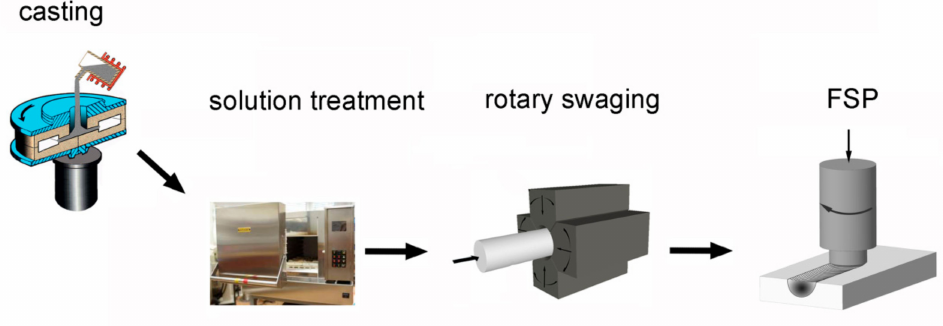
Figure 1. Schematic depiction of production process. FSP: friction stir